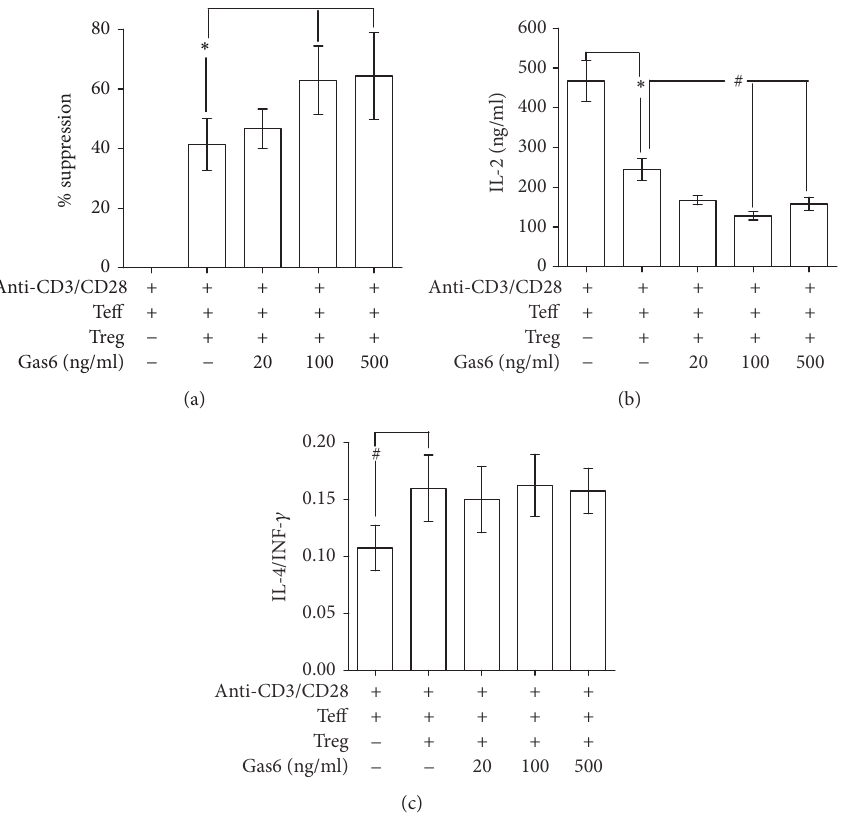
Figure 5: Effects of Gas6 on suppressive activity of CD4 + CD25 + Tregs in vitro. CD4 + CD25 + Tregs were pretreated with PBS or rmGas6, respectively, for 24 h. Then, prestimualted CD4 + CD25 + Tregs were mixed with CD4 + CD25 − T cells in the presence of anti-CD3/CD28 Abs. After72 h,theproliferationofCD4 + CD25 − Tcellsandthelevelsofcytokineintheconditionedmediaweredetermined.(a)Suppressiveactivity of CD4 + CD25 + Tregs was measured by a CFSE assay ( 𝑛 = 4 /group). The levels of IL-2 (b) as well as IL-4 and IFN- 𝛾 (c) in the conditioned media were determined by ELISA ( 𝑛 = 4 /group). ∗ 𝑃 < 0.05 compared with the value for the control Tregs group, and # 𝑃 < 0.05 compared with the value for anti-CD3/CD28